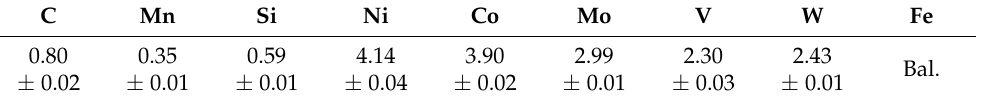
Table 1. Chemical composition (wt%) of the studied Böhler K890 Microclean steel.